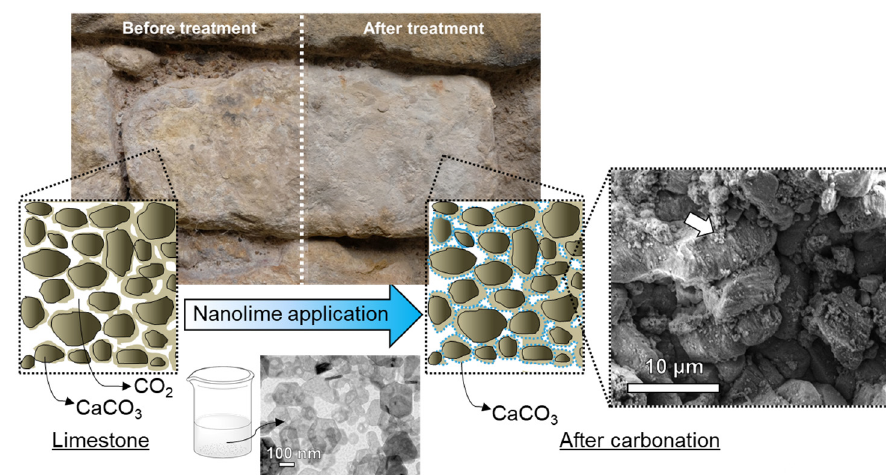
Figure 2. Lincolnshire limestone before and after the treatment with nanolime. Schematic representation of the application of calcium hydroxide nanoparticles (Transmission Electron Microscopy image), the formation of calcium carbonate after the reaction with carbon dioxide, and Scanning Electron Microscopy image of the consolidated stone.